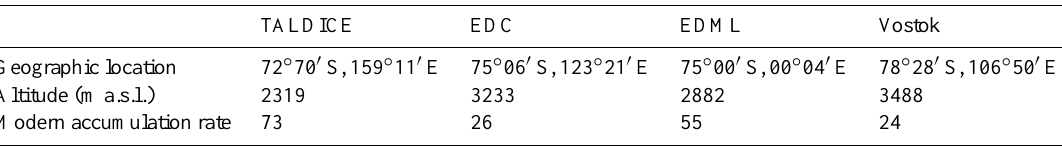
Table 1. Geographical and glaciological setting of the drill sites. Modern altitude is given in ma.s.l. (above sea level), average Holocene accumulation rates are given in (kgm − 2 a − 1